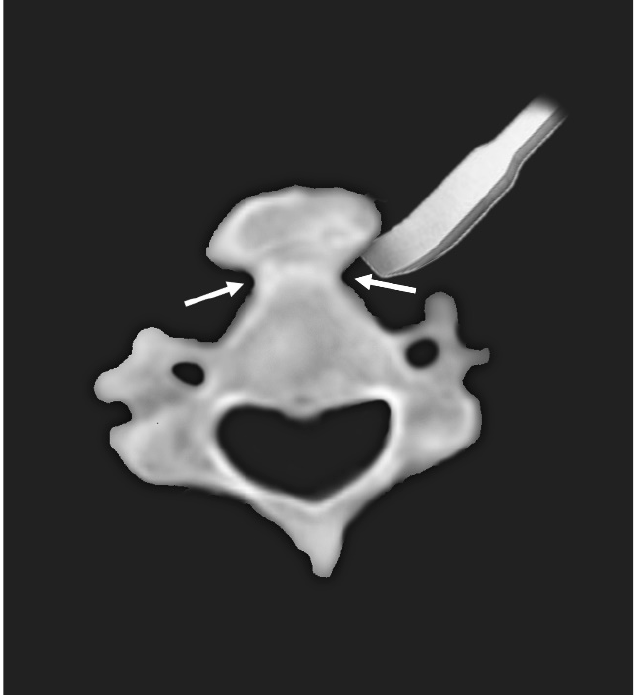
Figure 3. Diagram of typical axial appearance of anterior bony excrescence. Using the bottleneck point (arrows) between the vertebral body and bony excrescence, anterior osteophytes can be easily removed using an osteotome.